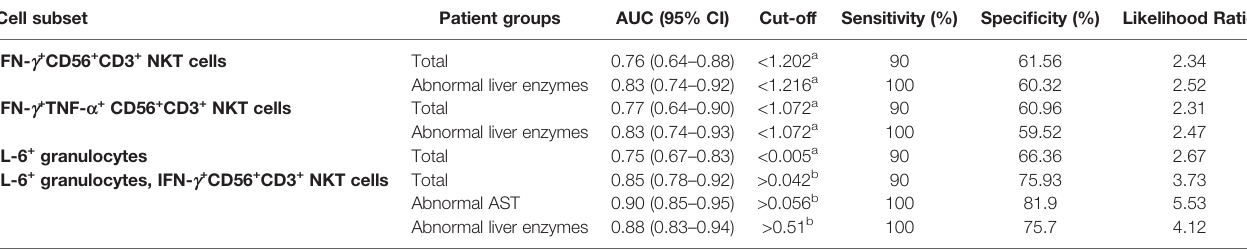
ROC analysis compared recovered DwoWS patients with those who worsened during the study. AU, area under the curve; CI, con fi dence interval; ROC, receiver operating characteristic; DwoWS, dengue without warning signs. Cut-off represents ( a ) % cytokine-secreting cells or ( b ) probability obtained from regression